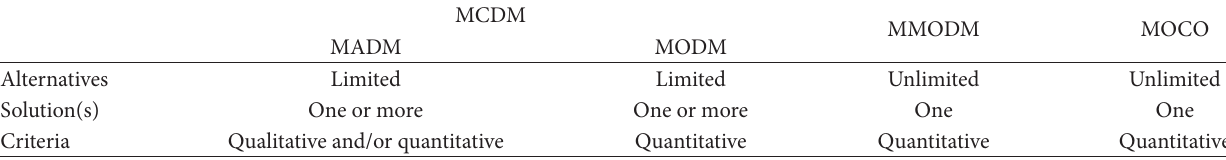
Table 2: Comparison of some characteristics between methods proposed for location selection of distribution